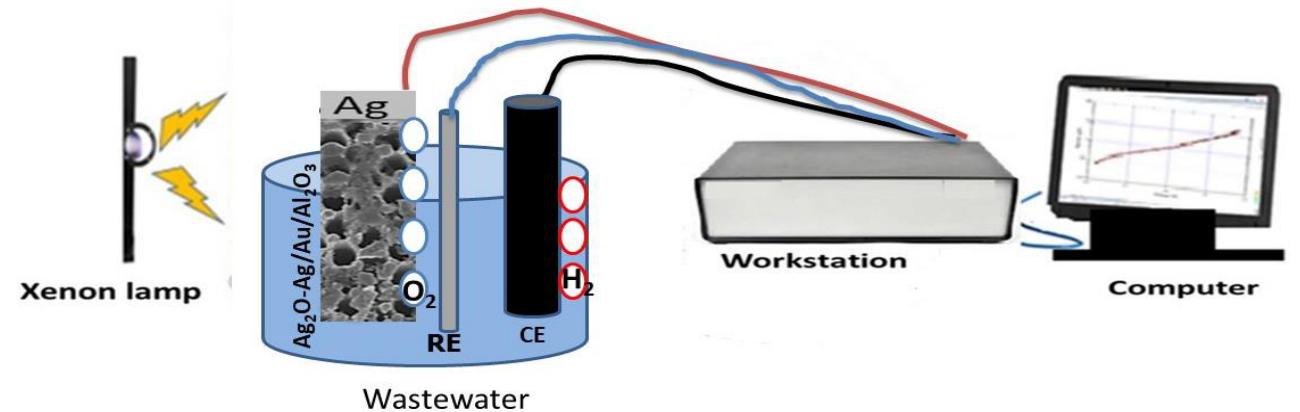
Figure 1. Diagram of the photoelectrochemical process for sewage water splitting reaction, in which Ag 2 O-Ag/Au/Al 2 O 3 is the working electrode (WE), graphite is the counter electrode (CE), and calomel is the reference electrode (RE).